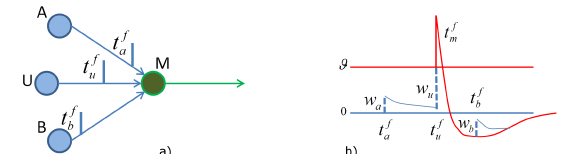
Figure 2: a) Spikes emitted by input neurons A , U and B reaching the synapse with postsynaptic motoneuron M at time t f a , t f u and t f respectively. b) The spike emitted by A b elicits an EPSP of amplitude w a , which is followed a few